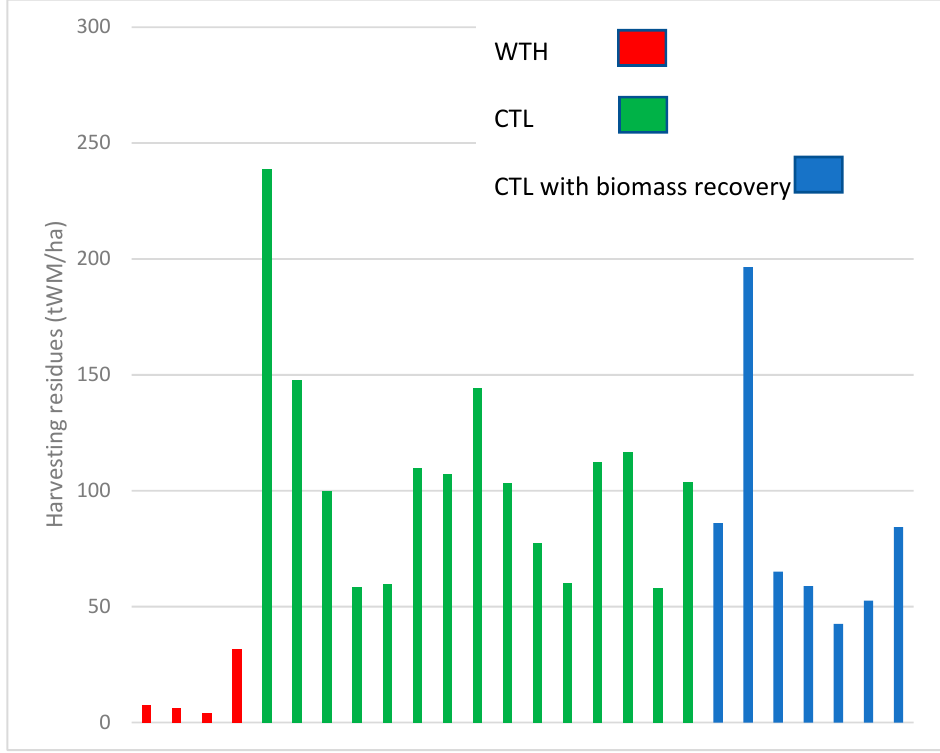
Figure 1. Weight of harvesting residues per hectare for all study sites and different harvesting methods.